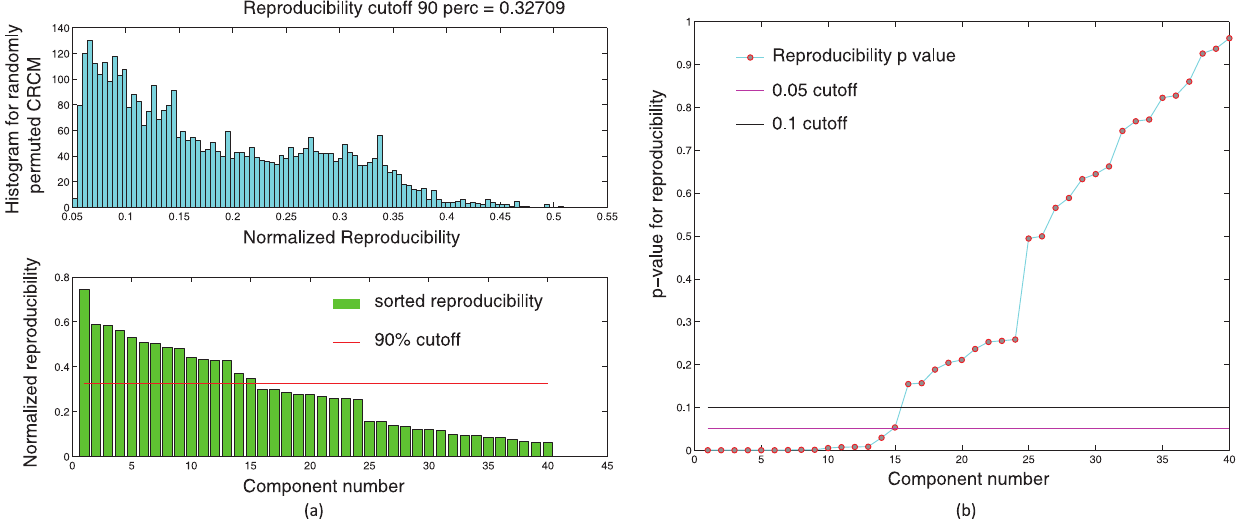
Figure 10. L ~ 5 subjects were randomly drawn from the set of N ~ 23 subjects and submitted to a temporal concatenation based group ICA. This process was repeated K ~ 50 times and the resulting ICA maps were submitted to a RAICAR-N analysis. Figure (a) shows the observed values of normalized reproducibility (bottom) as well as the ‘‘null’’ distribution of normalized reproducibility across R ~ 100 simulations (top). Figure (b) shows the p -values for each IC along with the 0 : 05 and 0 : 1 cutoff lines.